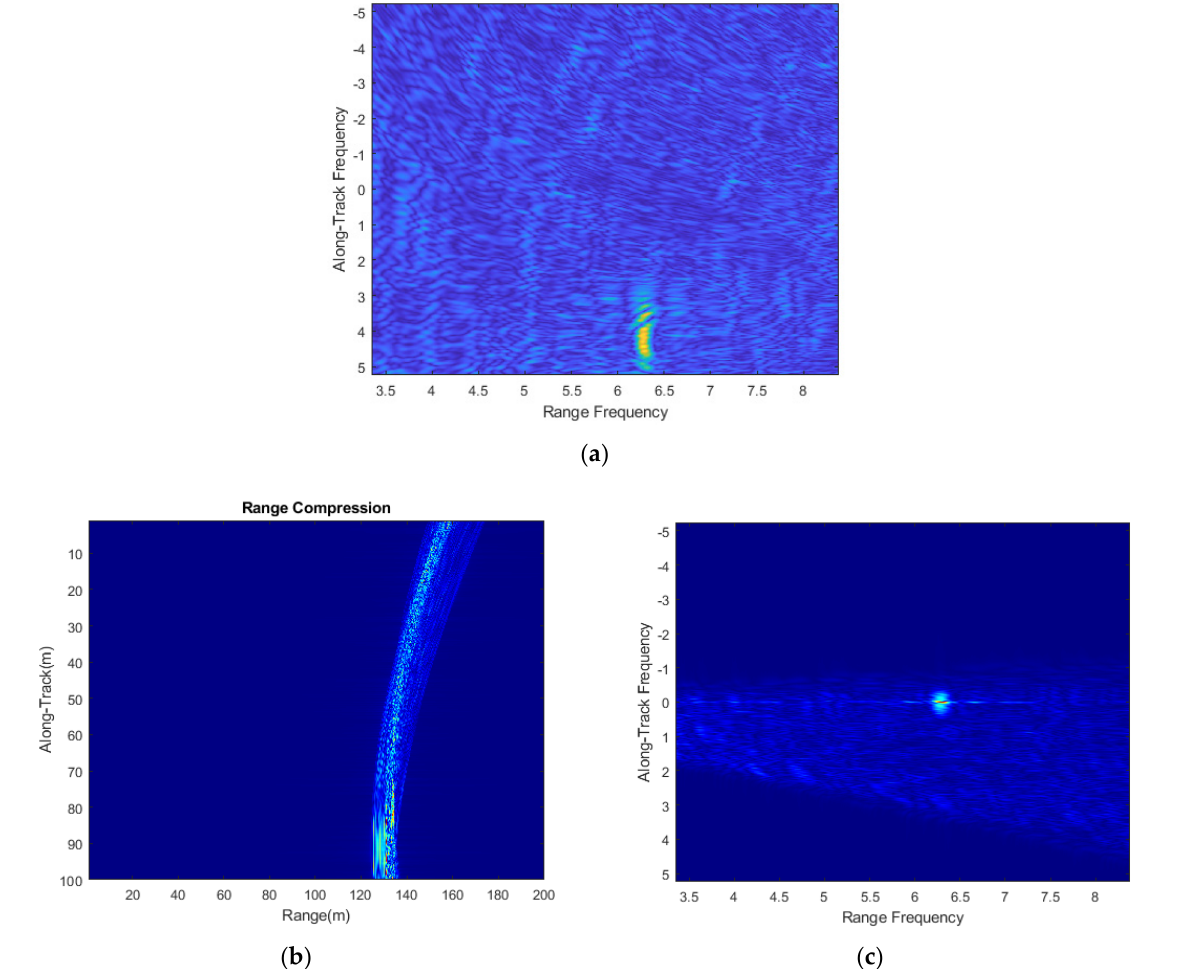
Figure 10. simulated collected data along SAS of pipeline: ( a ) Simulated data history of along-track and range; ( b ) simu- lated data history after pulse compression; ( c ) simulated data history after along-track compression.